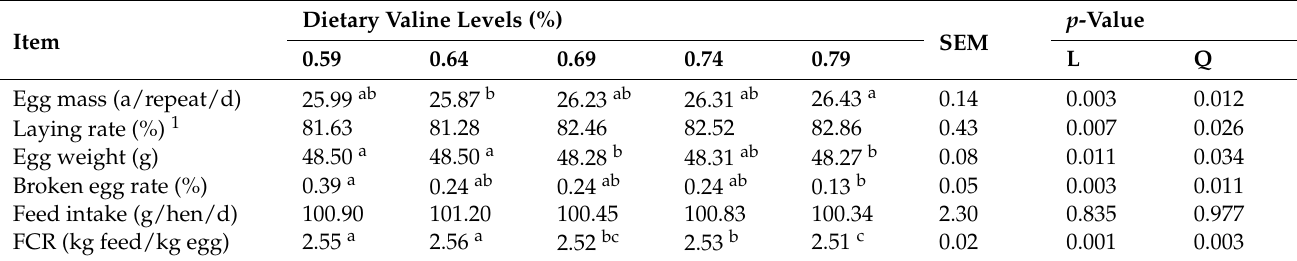
Table 3. Effects of dietary valine levels on productive performance of laying hens.